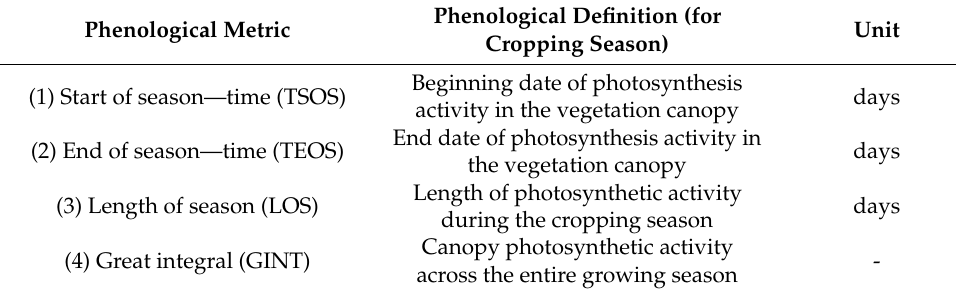
Table 2. Definition of the computed phenological metrics (PhM) [52–54].